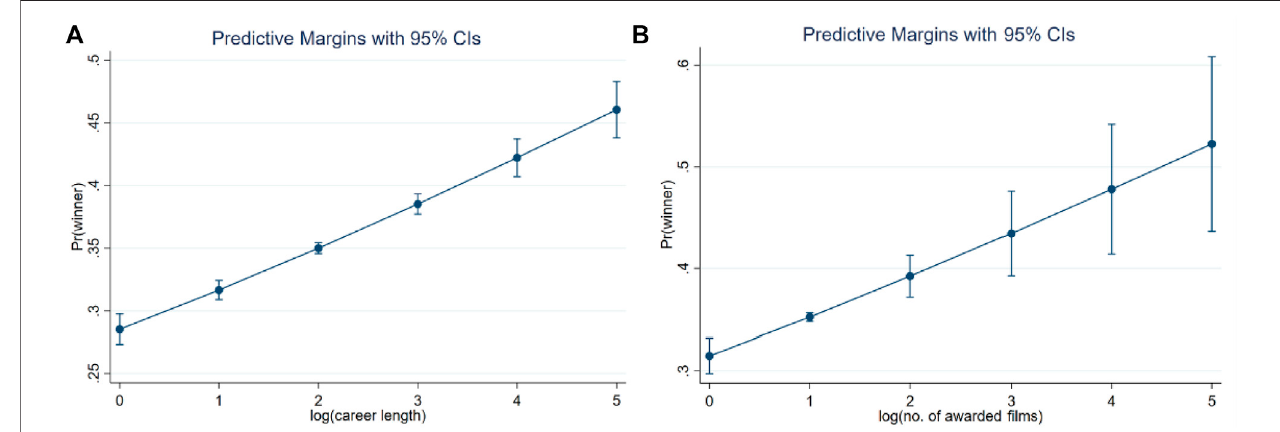
FIGURE 7 | Predictive marginal effects for historical performance. (A) Predictive marginal probability with increasing log career length, the predictive probability of winning after being nominated for performers with a career length above 8 years is more than 35%, while it drops to 30% for performers with career lengths less than